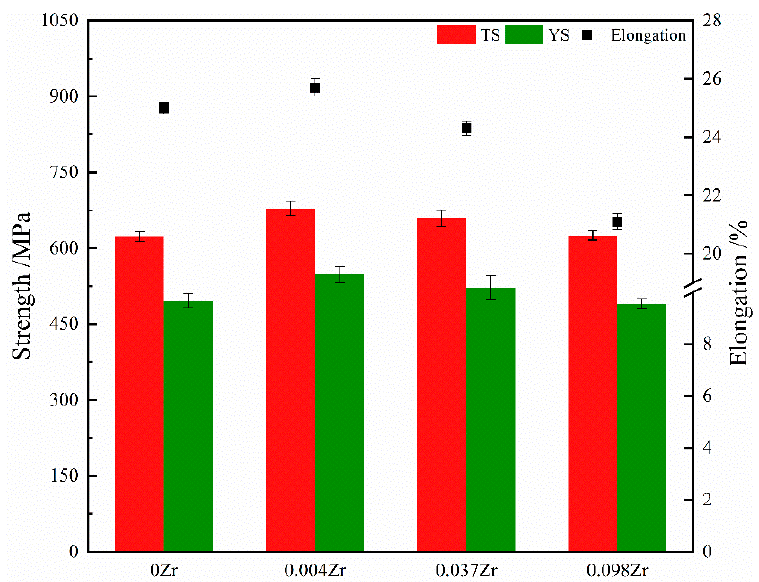
Figure 4. Tensile properties of CLAM steel with Zr. Error bars correspond to one standard deviation from the mean value.